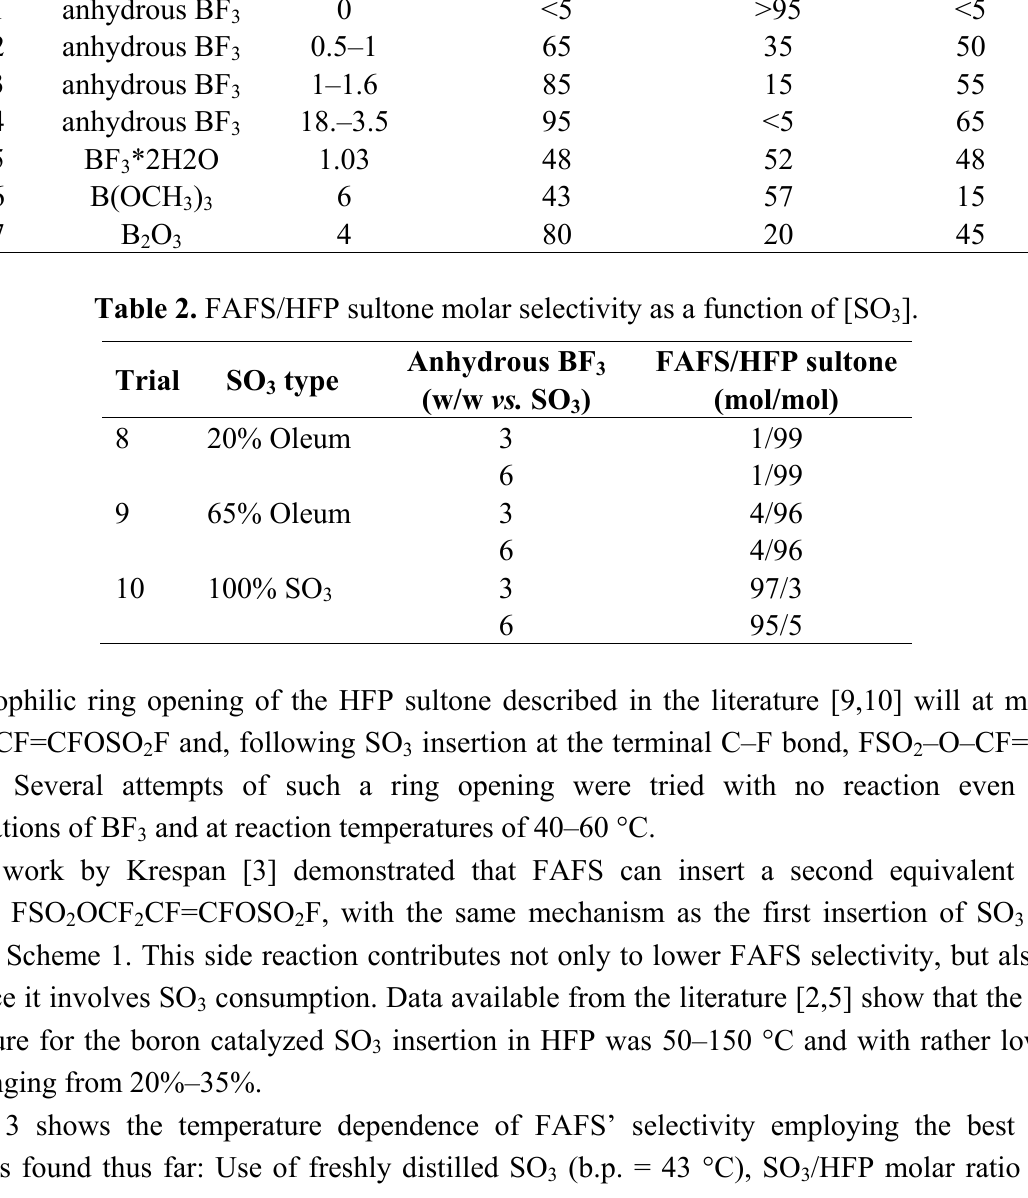
Table 1. FAFS selectivity and yield as a function of Boron catalyst type or born catalyst concentration.